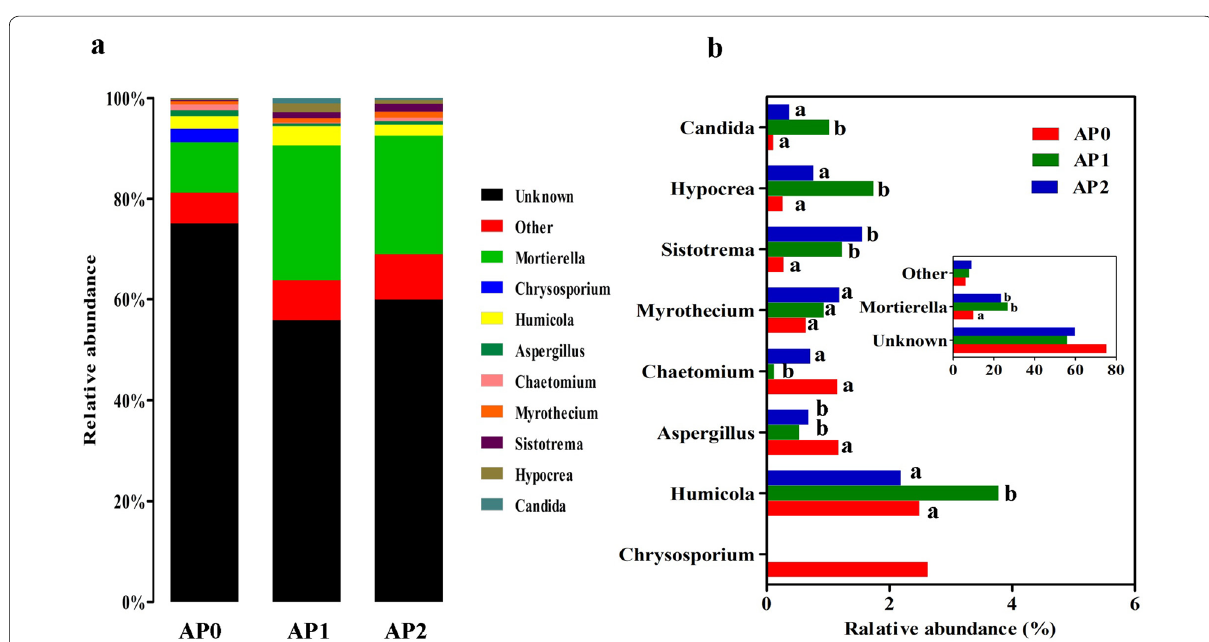
Fig. 7 Relative abundance of the dominant fungal genus in the soils continuously cropped Andrographis paniculata. a Fungal community composition at genus level. b Variations of fungal community composition. Only genera with more than 1% relative abundance in at least one sample were shown and different letters mark significant difference at P < 0.05. The “Other” group contained the genera with relative abundance < 1%. AP0, AP1 and AP2 represent soils with continuously cropping histories of A. paniculata for 0, 1 and 2